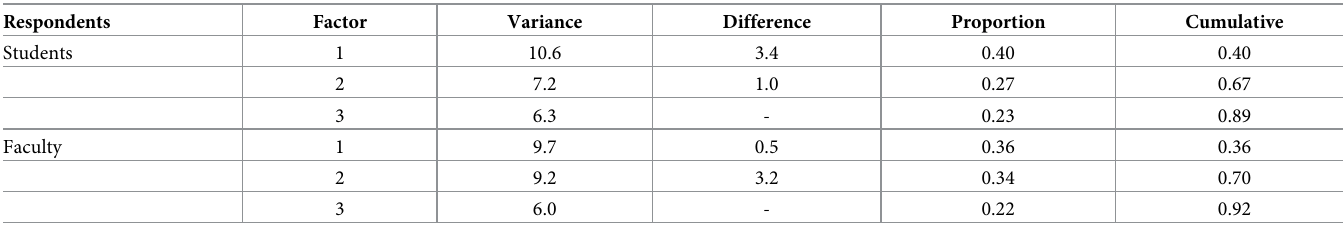
Table 6. Principal factor analysis and variance, orthogonal varimax rotation.